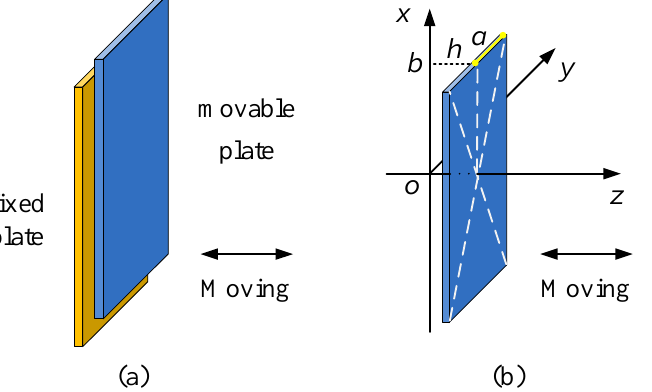
Figure 3. ( a ) Squeeze-film air damping between the movable electrode plate and fixed electrode plate in the capacitive accelerometer, ( b ) schematic diagram of squeeze-film air damping.